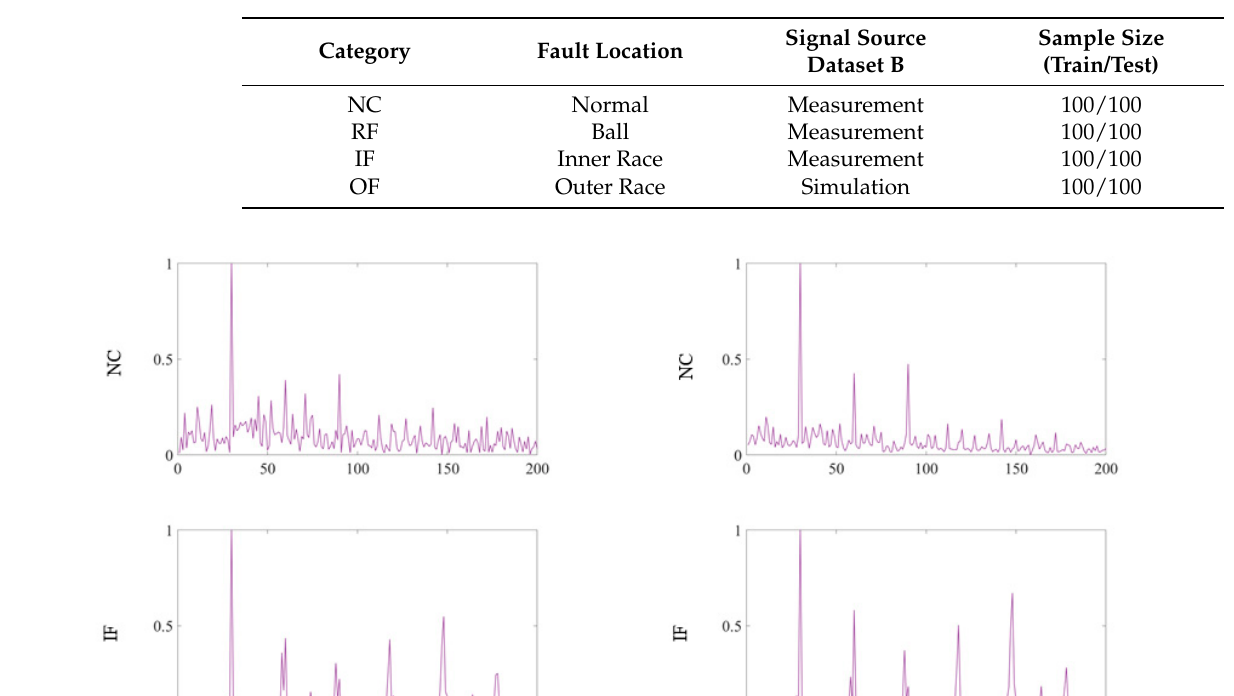
Table 3. Situation of Dataset B.